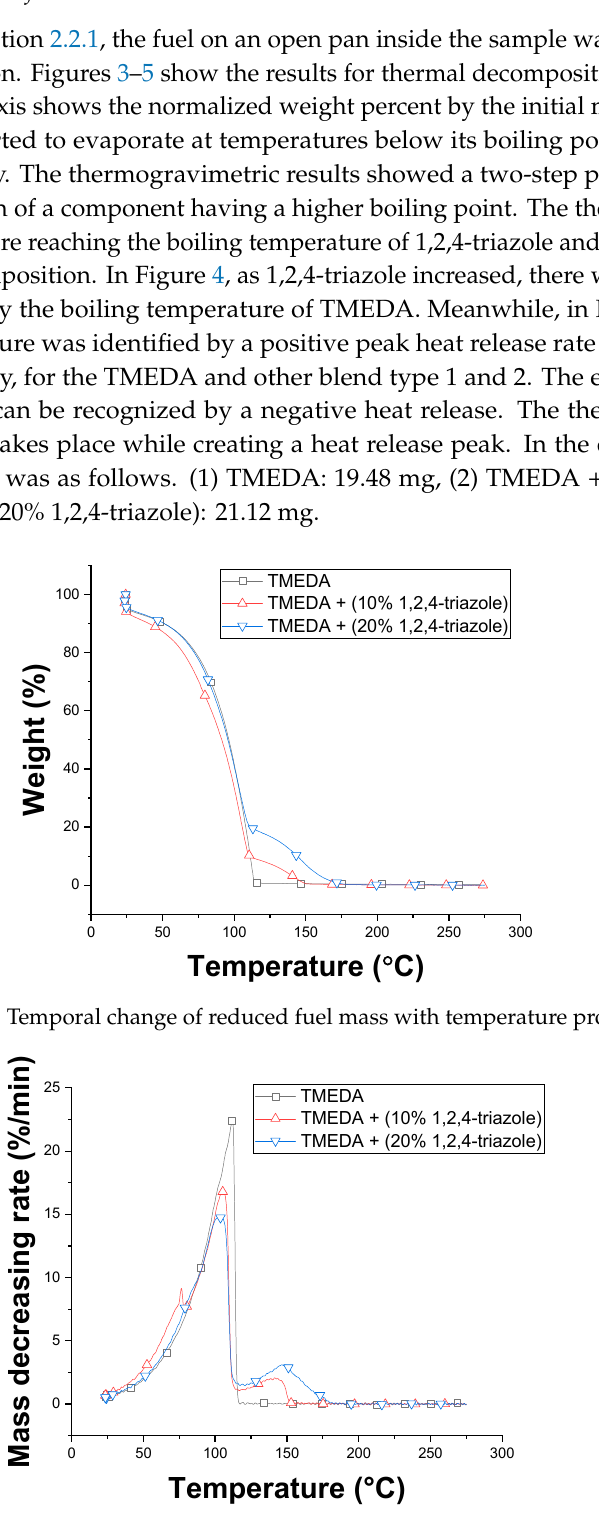
Figure 4. Temporal change of decreasing rate of fuel mass.